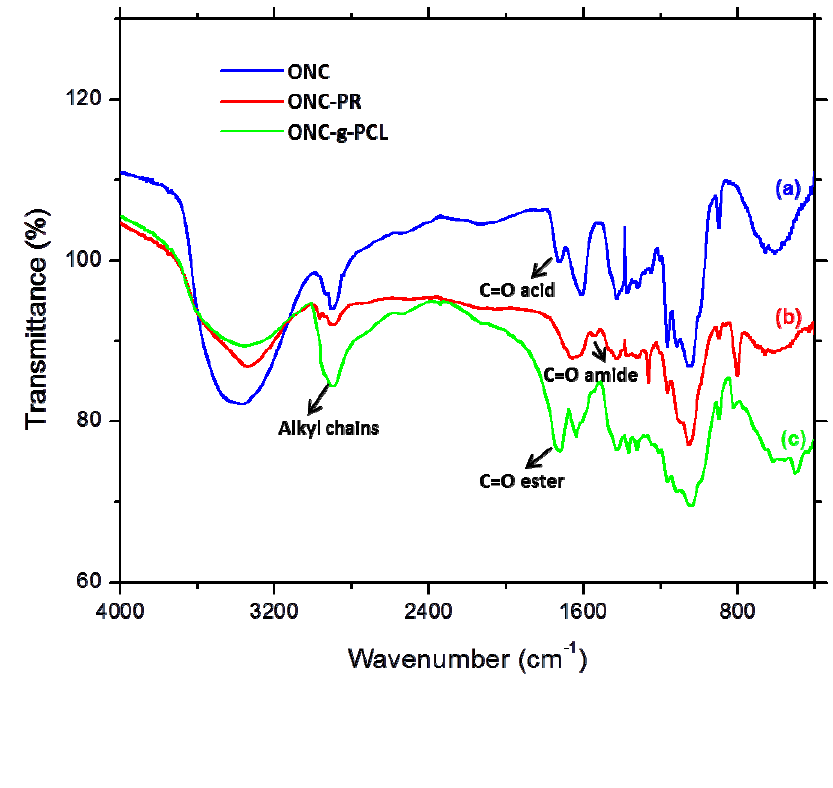
Figure 2. Fourier transform infrared spectroscopy (FTIR) spectra of oxidized nanocelluloses (ONC) alone ( a ), ONC-propargylamine (PR) ( b ) and ONC-g-polycaprolactone (PCL) ( c